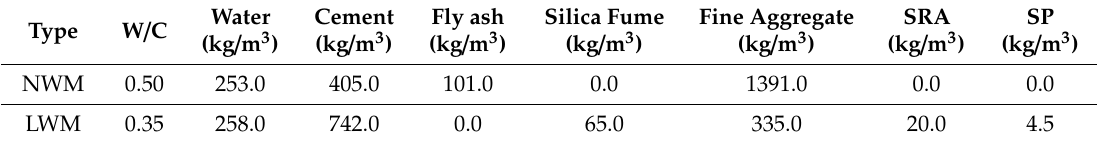
Table 1. Mix proportions of mortars (target strength = 50 N / mm 2